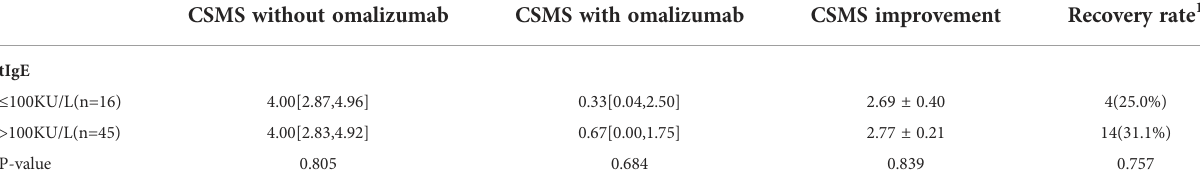
TABLE 4D In fl uence of tIgE before omalizumab